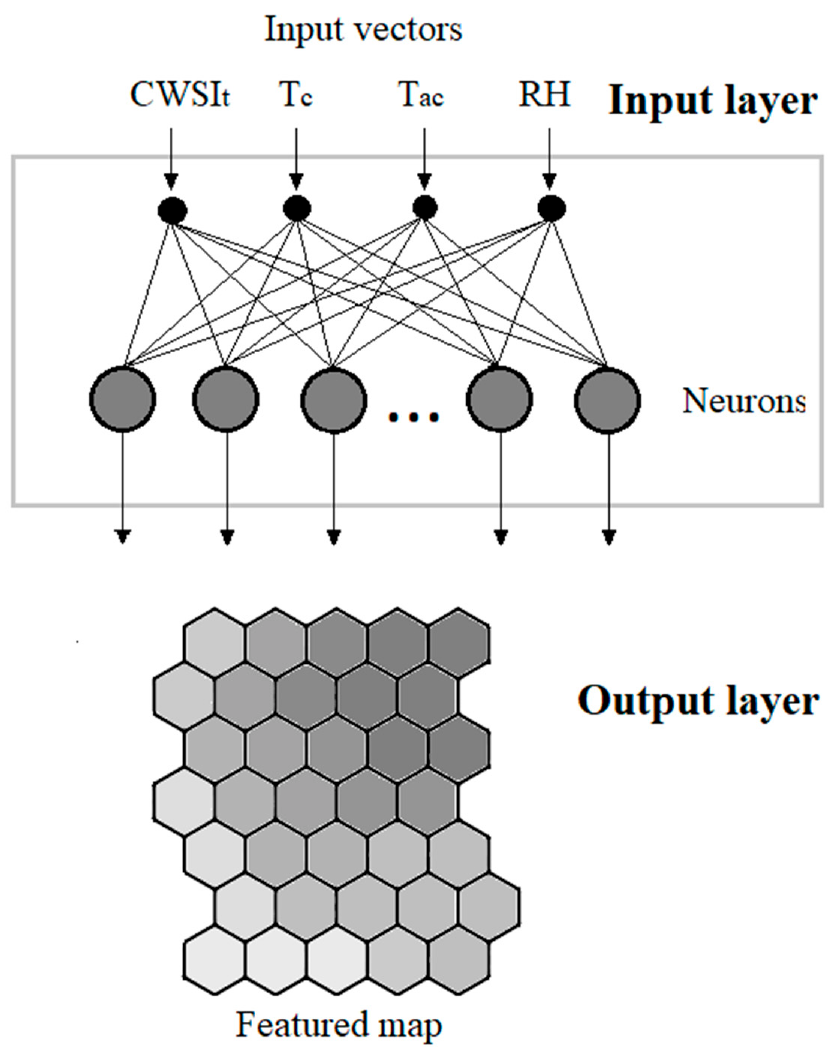
Figure 1. Schematic representation of the input and output vectors in the self-organization map K- SOM.